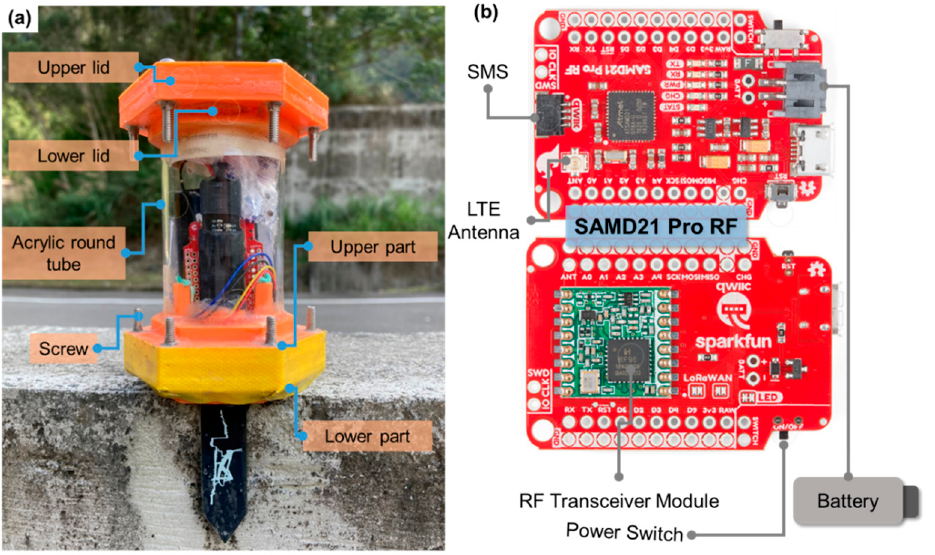
Figure 1. Wireless underground transmission sensor: ( a ) external configuration and finished product of the sensor: ( b ) internal configuration.